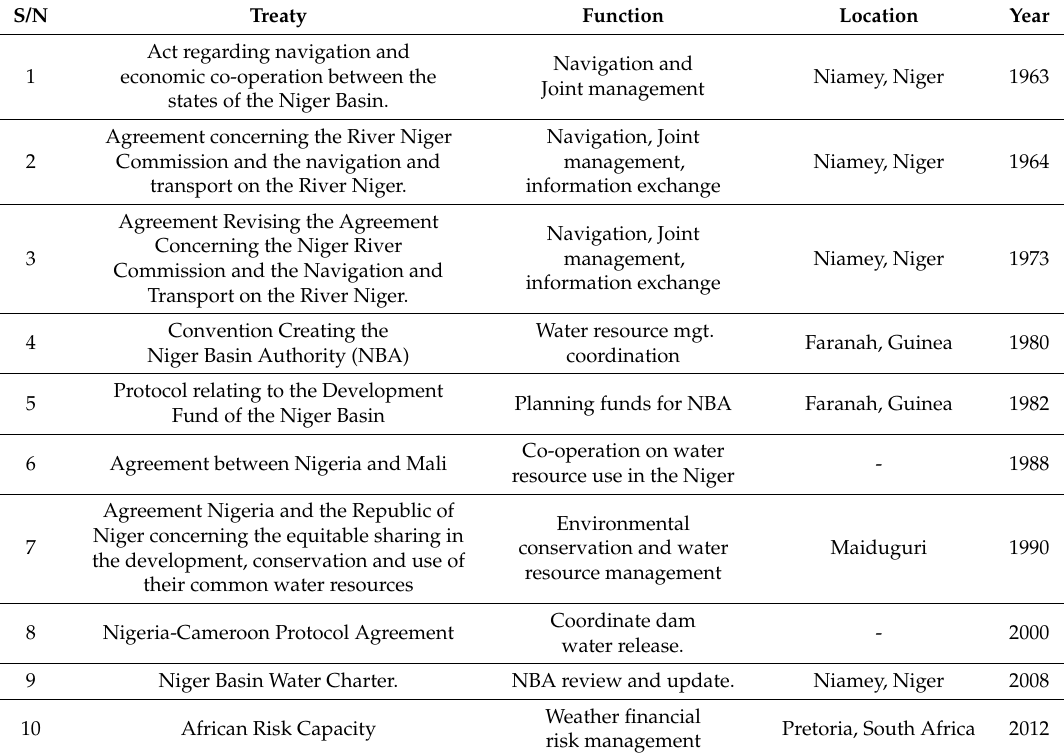
Table 7. Niger River Basin Agreement, Nigeria. Adapted from